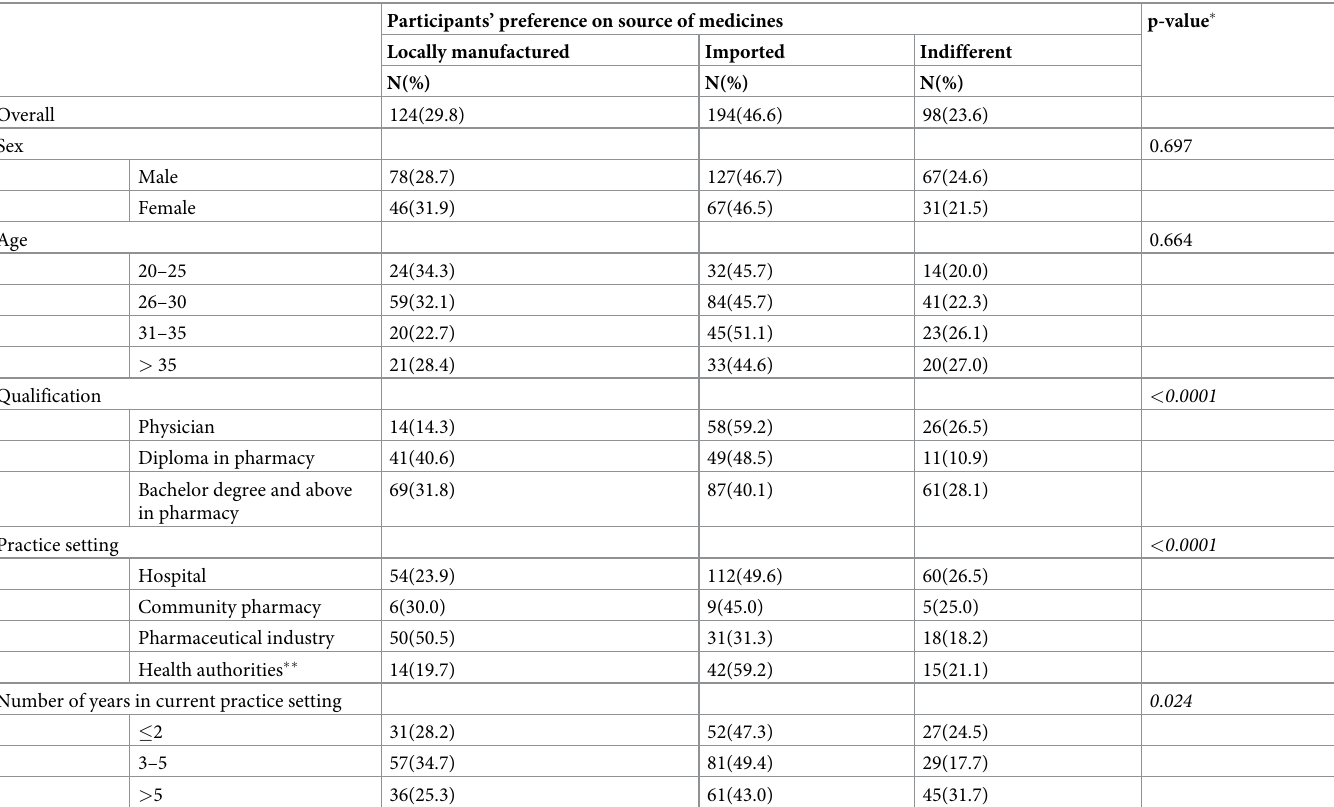
Table 2. Medicine source preferences and associated factors among health professionals practicing in Addis Ababa,